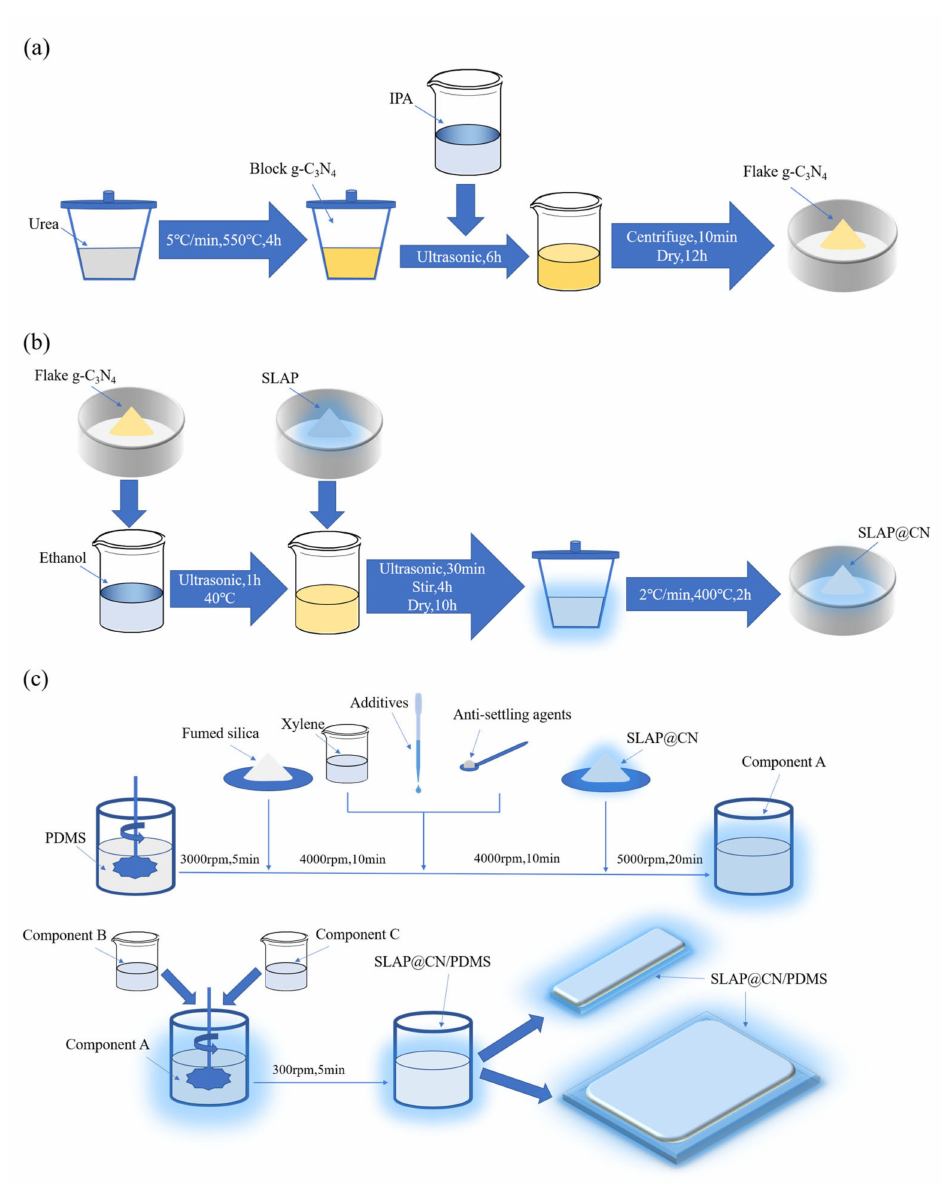
Figure 1. ( a ) Preparation flow chart of flake g-C 3 N 4 ; ( b ) preparation flow chart of SLAP@CN; ( c ) preparation flow chart of SLAP@CN/PDMS composite antifouling